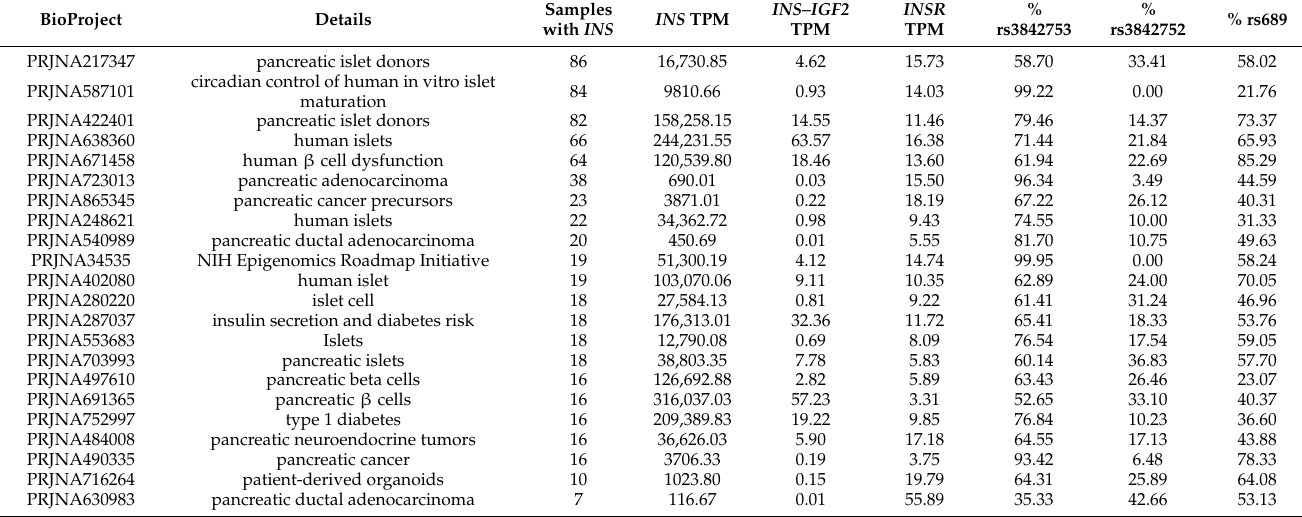
Table 1. BioProjects with INS expression from